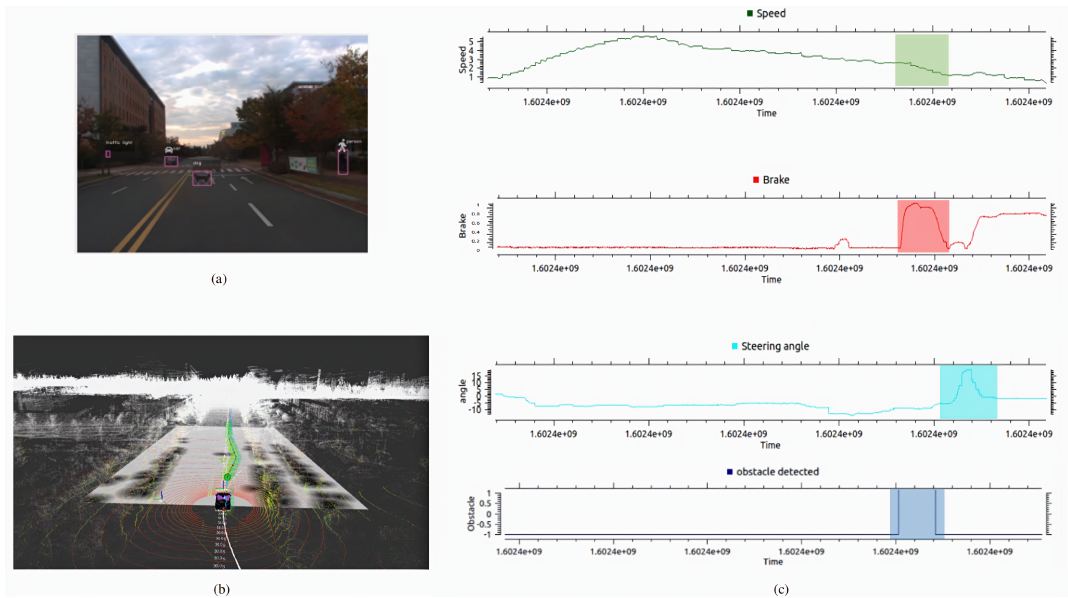
Figure 15. The quantitative evaluation of obstacle avoidance using the proposed autonomous vehicle is illustrated. ( a ) Obstacle is detected in the camera frame using YOLOv3. ( b ) Obstacle is detected in the Lidar frame using PointPillar and upon detection the waypoints are changed and velocity is replanned using velocity replanning module and obstacle is avoided by complying the traffic rules using the state-machine configuration. ( c ) illustrates the quantitative graphs of obstacle avoidance using proposed autonomous vehicle. The spike in the steering angle graph shows the change of angle in positive direction. In the graphs it is shown that first the obstacle is detected, the vehicle speed is lower down and brake is applied, and in that case it is possible for the autonomous vehicle to avoid the obstacle by not violating the traffic rules, the autonomous vehicle has avoided the obstacle